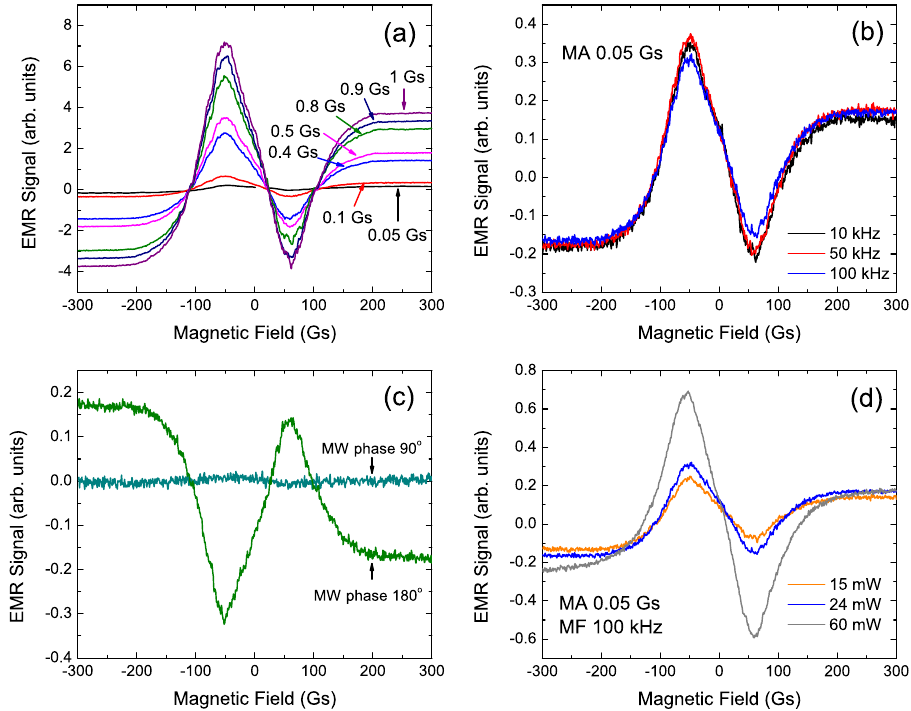
Figure 6. The LFMA signal for Ni 45 Co 5 Mn 35.5 In 14.5 ribbon at 370 K: signal changes depending on modulation amplitude at modulation frequency 100 kHz ( a ); the LFMA signal registered for several modulation frequencies (modulation amplitude equal to 0.05 Gs) ( b ); the LFMA signal obtained in the two different microwave radiation phase ( c ) and microwave power dependence of the LFMA signal measured at modulation frequency 100 kHz and modulation amplitude equal to 0.05 Gs ( d